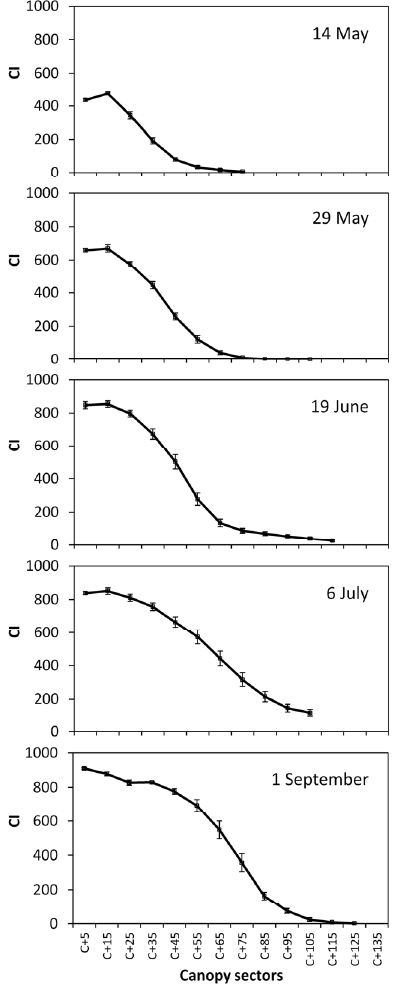
Figure 7. Variation over measuring dates and canopy sectors of the Canopy Index ( CI ). Canopy sectors are shown on x-axis as C + n where n indicates distance in cm from the supporting wire held at 70 cm from the ground. Vertical bars indicate standard error, for n = 24.)